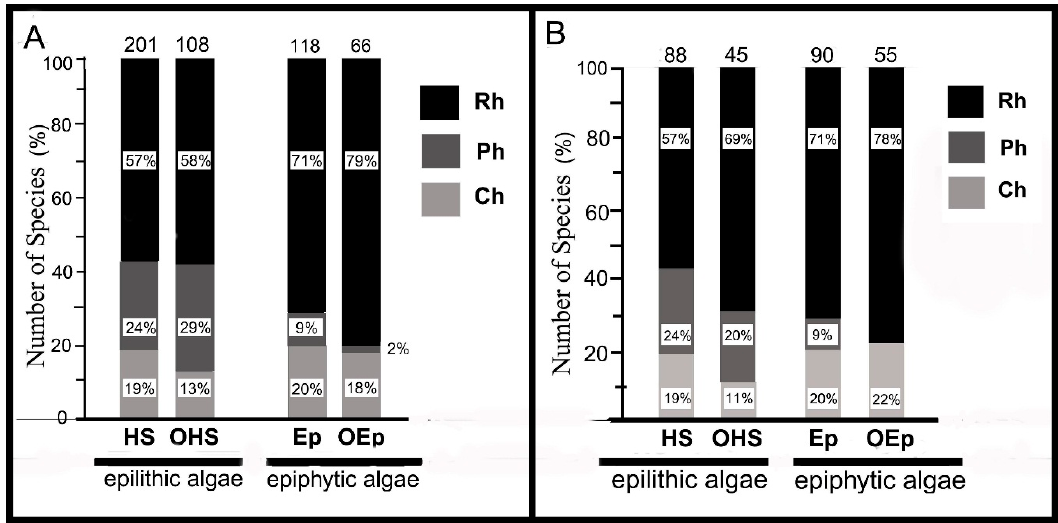
Figure 3. Relative species number from the Phyla Rh, Ch, and Class Ph in different groups of epilithic and epiphytic benthic algae of the collection of 2012 − 2017: HS, algae growing on hard natural substrates; OHS, algae growing only on hard natural substrates; Ep, algae growing epiphytically; OEp, algae growing only epiphytically. Numbers above the columns are total number of species in individual groups. ( A ) Collection of benthic macroalgae sampled in 2012 − 2017. ( B ) New findings in the collection of 2012 − 2017.